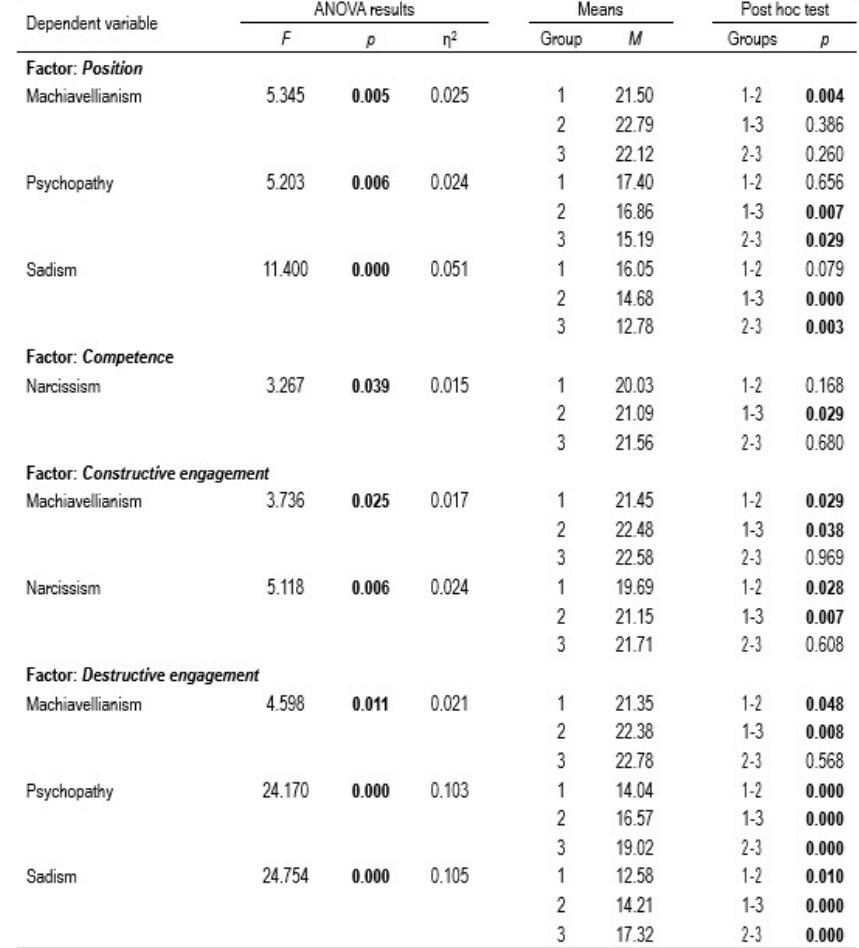
Table 5 ANOVA for factors of the cyber socialization engagement